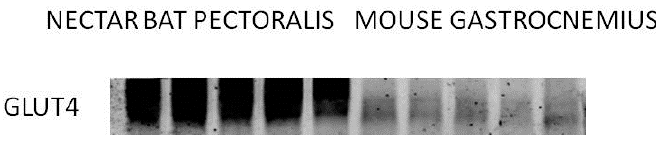
Figure 5. Western blot showing much higher GLUT4 expression in nectar bat ( Glossophaga soricina ) pectoralis muscles (lanes 1–5) than in mouse gastrocnemius (lanes 6–10). 40 µ g protein was loaded into each lane. Staining intensity in nectar bat lanes was sixfold greater than in mouse gastrocnemius